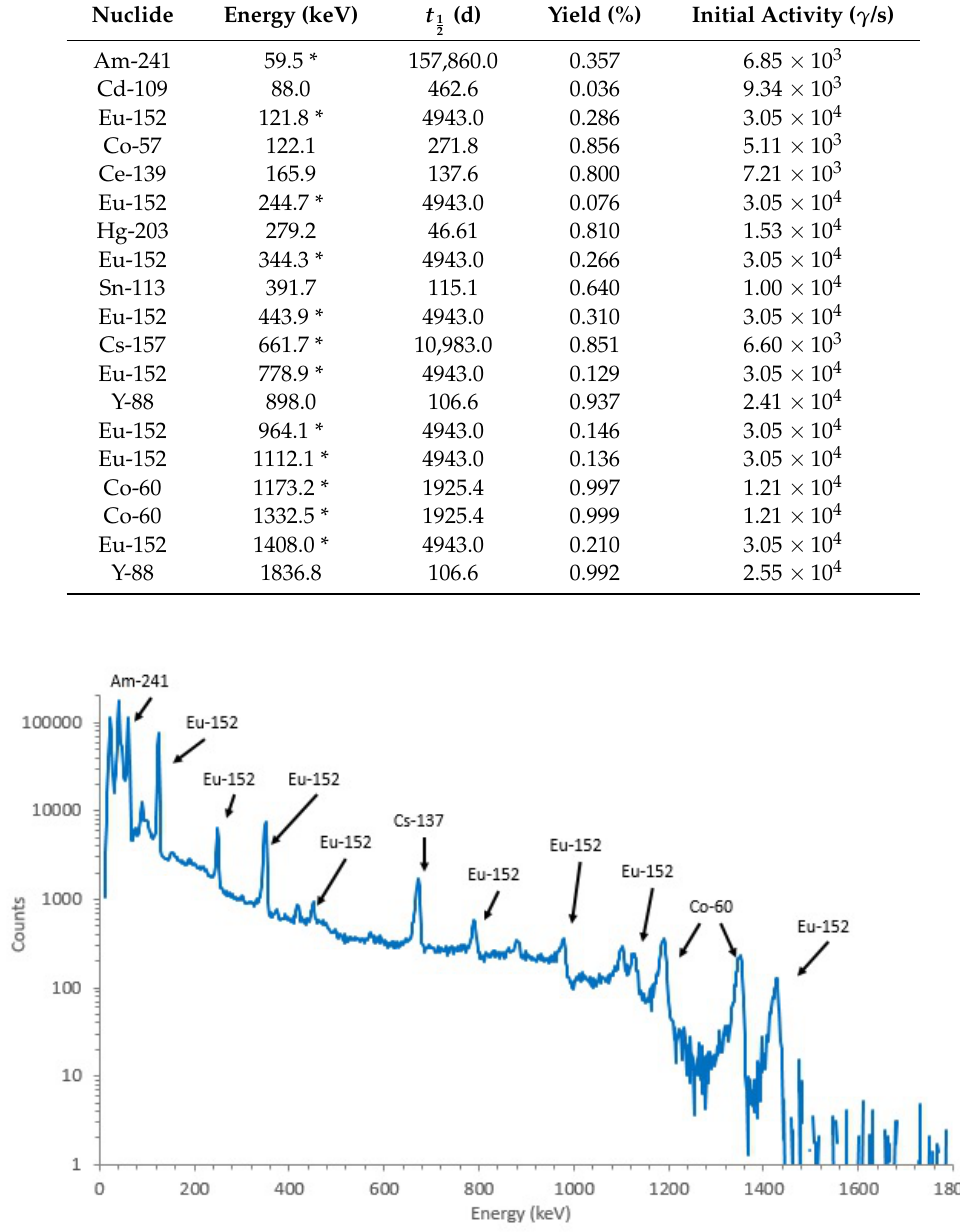
Figure 3. Acquired calibration spectrum (background subtracted). Labeled peaks were considered for calibration. Time of acquisition was 86,400